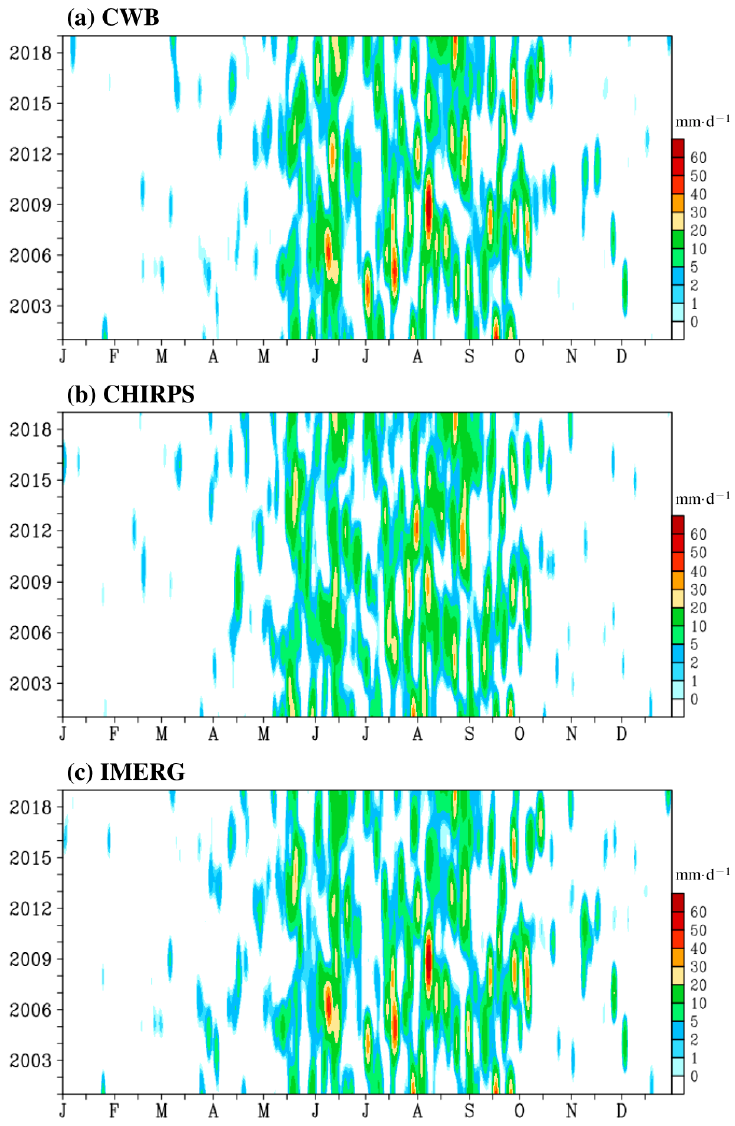
Figure 6. Year ( y -axis) versus date ( x -axis) of area-averaged daily precipitation over Taiwan during 2001–2019 estimated from ( a ) CWB, ( b ) CHIRPS, and ( c ) IMERG.